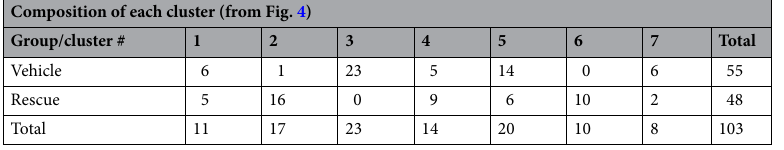
Table 3. All females—clusters—12 markers. Summary of female AM cluster analysis. The female AM data were subjected to cluster analysis (see Fig. 4) and the composition (Vehicle or SP-A1 rescue) of each cluster is shown in this table. When all 103 AM from the female samples were subjected to cluster analysis based on their CMP content, 7 clusters were defined and the makeup of each cluster is shown in this table.